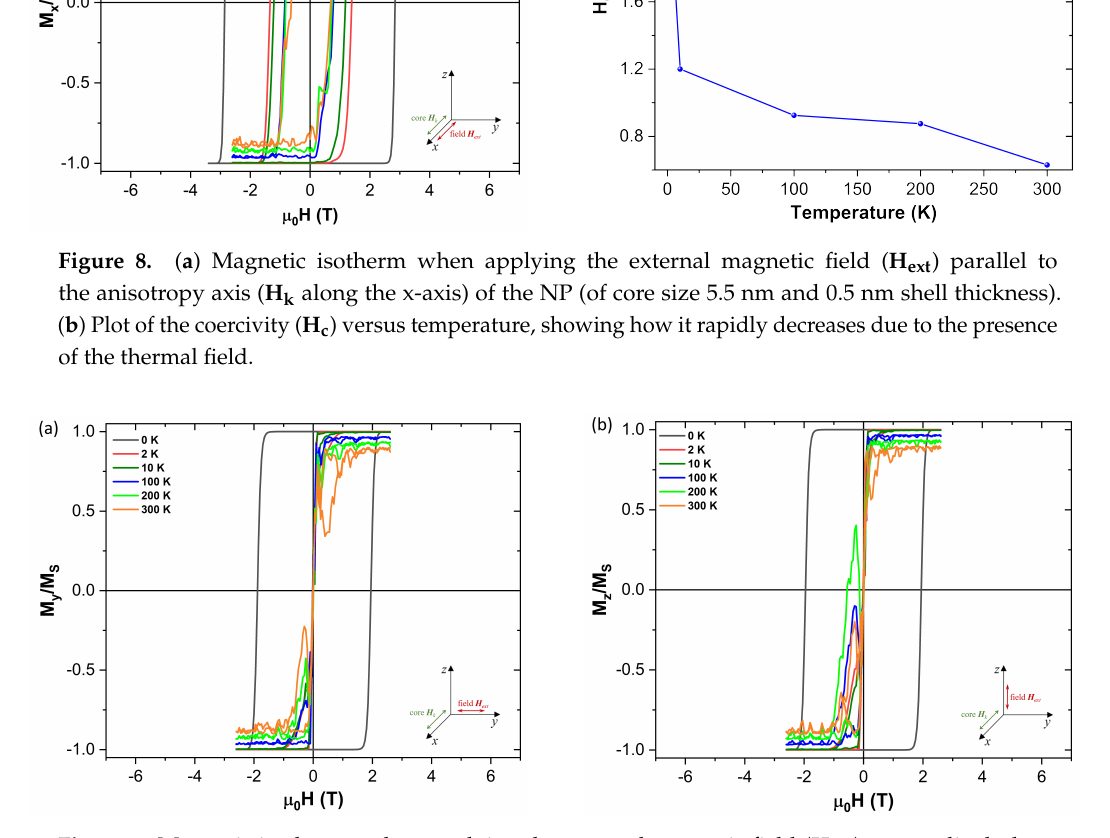
Figure 9. Magnetic isotherms when applying the external magnetic field ( H ext ) perpendicularly to the ordered core anisotropy direction ( H k along the x-axis) of the NP (of core size 5.5 nm and 0.5 nm shell thickness). ( a ) When the field is applied along the y-axis and ( b ) when the field is applied along the z-axis. The coercivity rapidly tends to zero as soon as the thermal field is added, when the external magnetic field is applied perpendicularly to the anisotropy easy